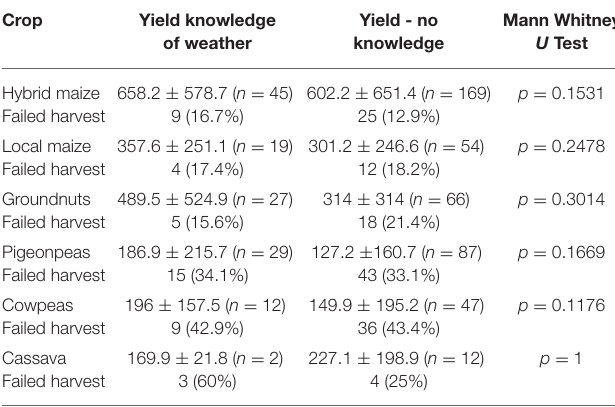
TABLE 3 | Crop yields for farmers who were aware of erratic rainfall and those who were not. Crop Yield knowledge of weather